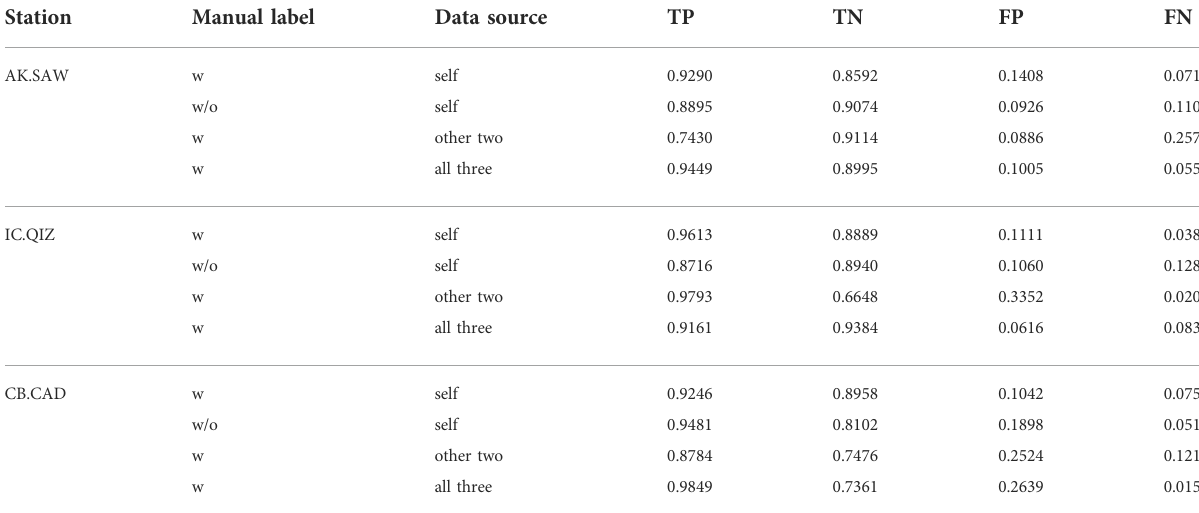
TABLE 3 Normalized confusion matrixes of the CNN-BiLSTM model used with or without manually labeled datasets from station itself, other two stations, or all the three stations. W means training set with manual labels and w/o means training set without manual labels. Station Manual